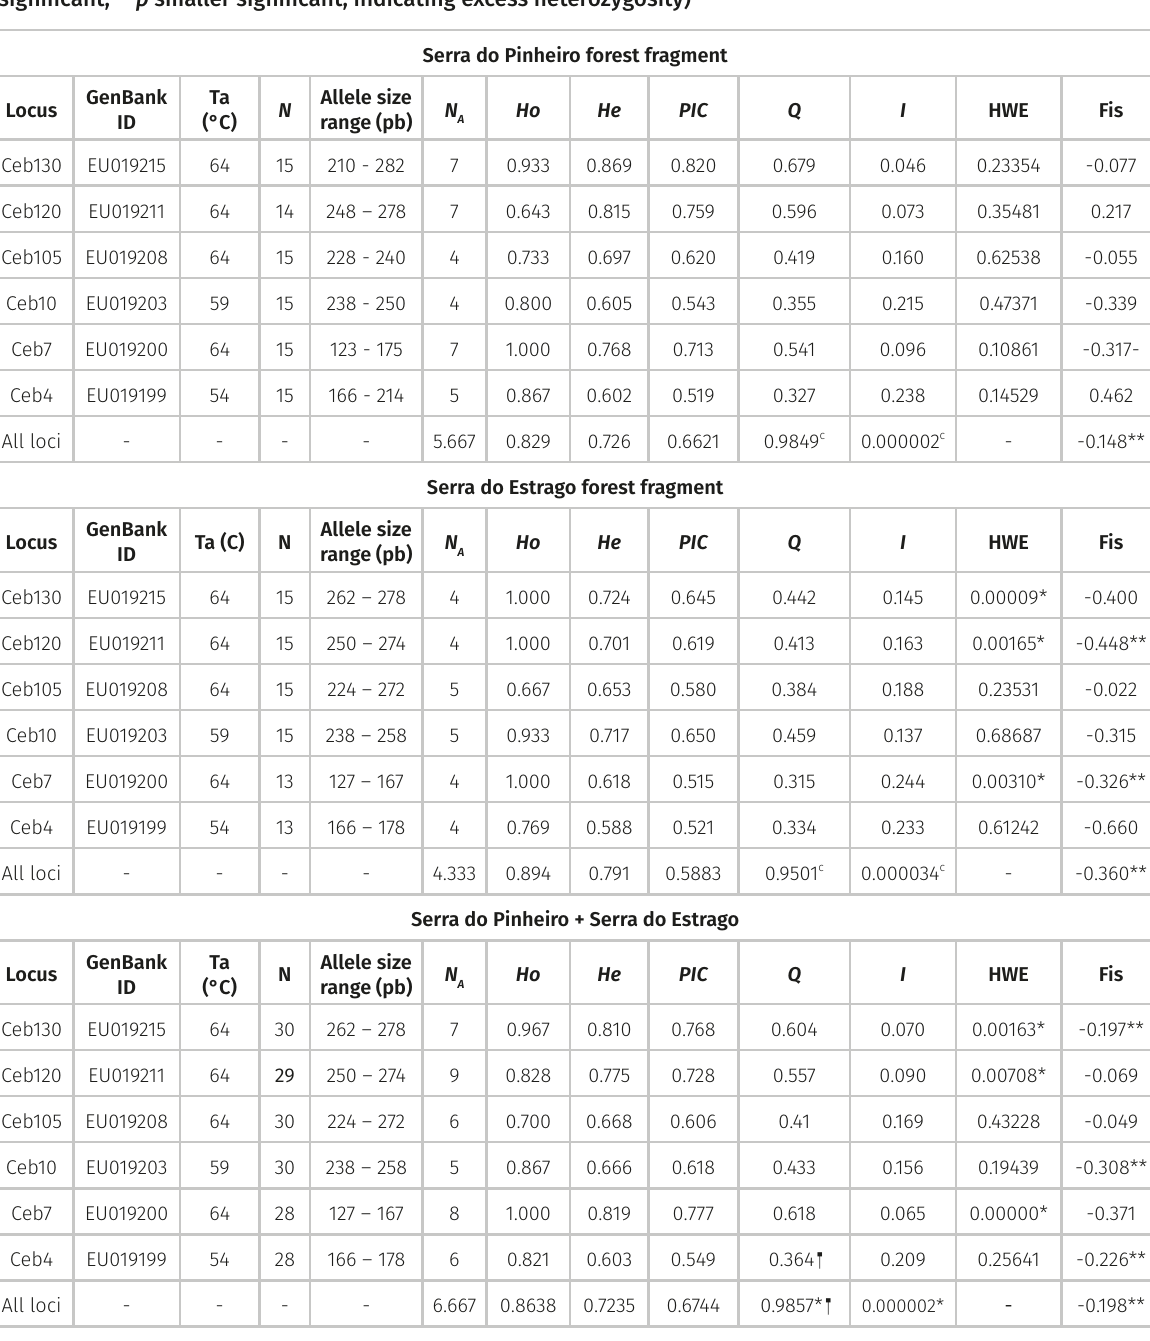
Table I. Genetic characterization, of the six microsatellite loci transferred to Sapajus libidinosus living in Serra do Pinheiro and Serra do Estrago in Sertânia municipality, Pernambuco State, north-eastern, Brazil. N- number of individuals tested, Ta – annealing temperature, (NA ) Number of alleles, ( Ho ) observed heterozygosity, ( He ) expected heterozygosity, (PIC) polymorphic information content, ( Q ) probability of paternity exclusion, ( I ) identity index, (HWE) Hardy–Weinberg equilibrium ( p = 0.0083 after Bonferroni correction) and (Fis) fixation index (p = 0.00341 for localities separately, and p= 0.0083 for single population after Bonferroni correction); c combined probability, *significant; ** p smaller significant, indicating excess